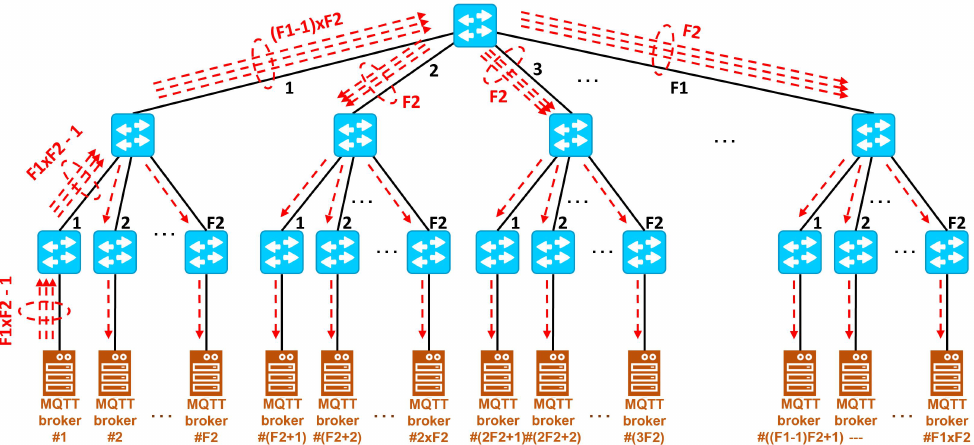
Figure 13. Packets retransmitted within the SDN network due to one incoming packet using unicast, e.g., with typical MQTT